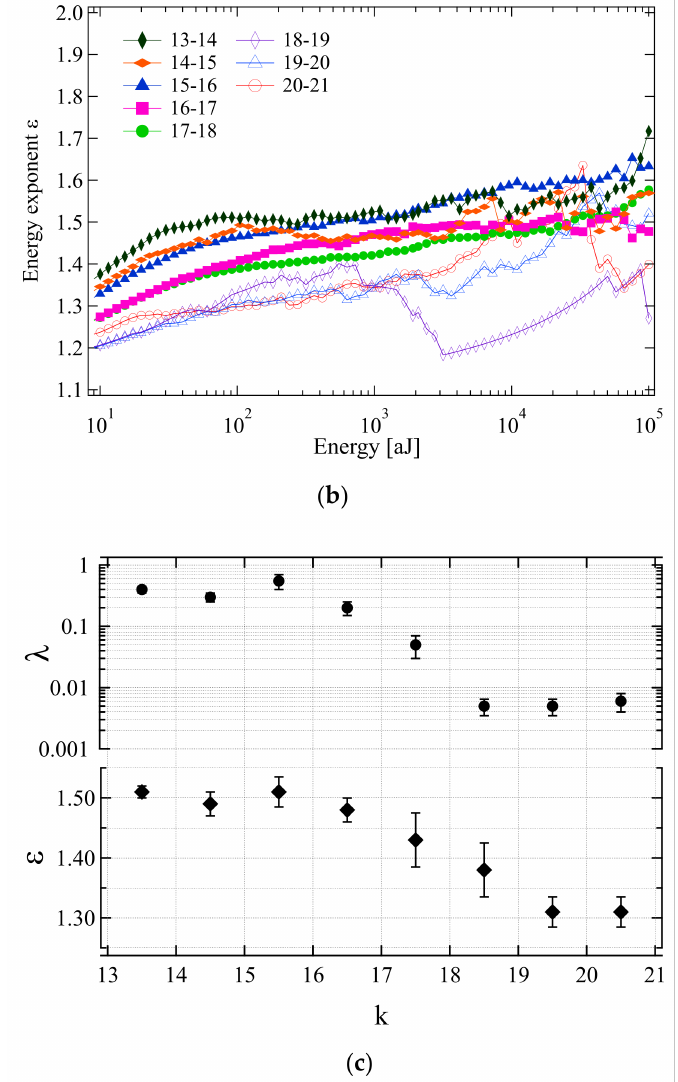
Figure 5. Energy exponent as a function of the lower energy cut-off determined by maximum likelihood (ML) estimate. ( a ) Energy exponents determined by the maximum likelihood method for k-intervals 13–14 and 20–21 with error bars and estimate values; ( b ) energy exponents for all intervals between k = 13 and k = 21. Sparse data sets lead to a less defined plateaus. We used data near 103 aJ to determine the energy exponents. ( c ) Evolution of the waiting time renormalization factor λ and the energy exponent ε with increasing rank k of superjerks. Two plateaus can be distinguished for large and small λ and exponents near ε = 1.5 and ε = 1.32. Reproduced with permission from [59]. American Physical Society,